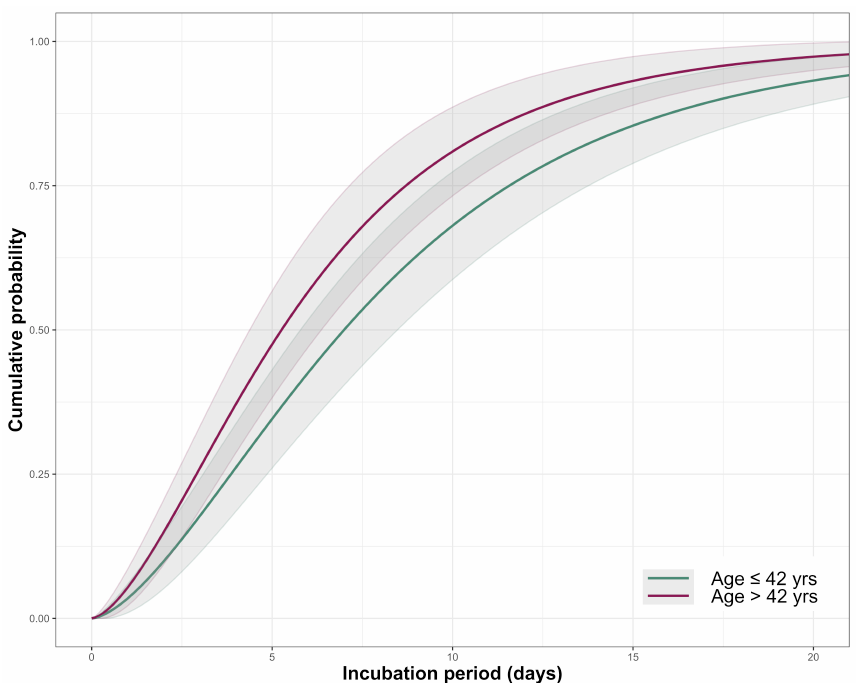
Figure 3. The estimated cumulative distribution of the incubation period by two age